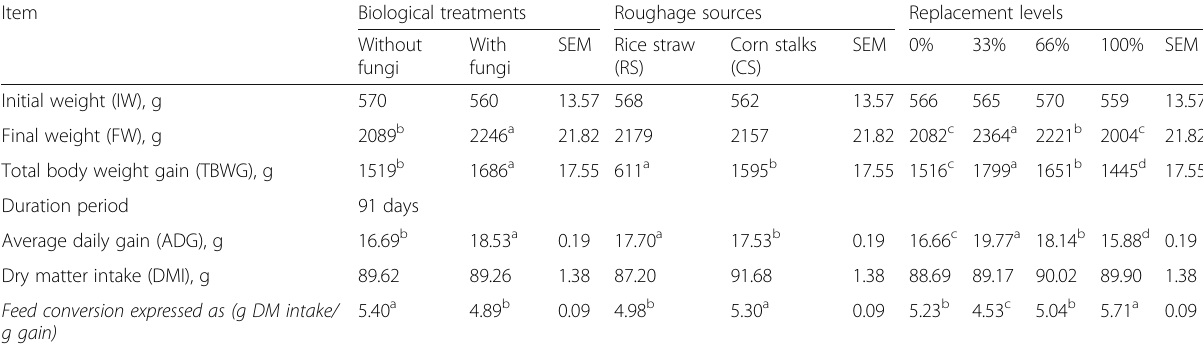
Table 4 Main effect of biological treatments, roughage sources and replacement levels on growth performance of the experimental groups